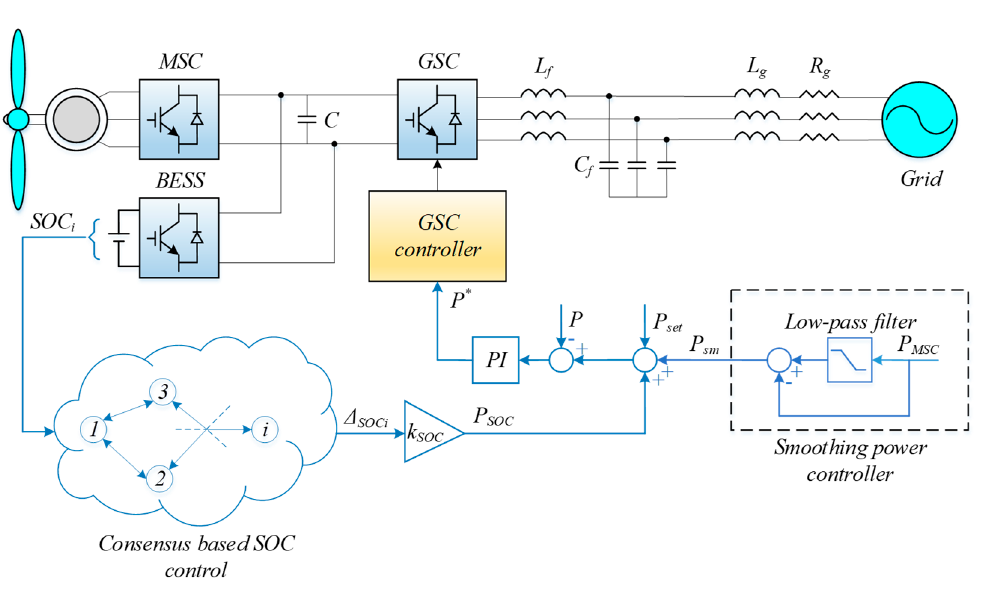
Figure 3. Control diagram of the proposed control strategy.